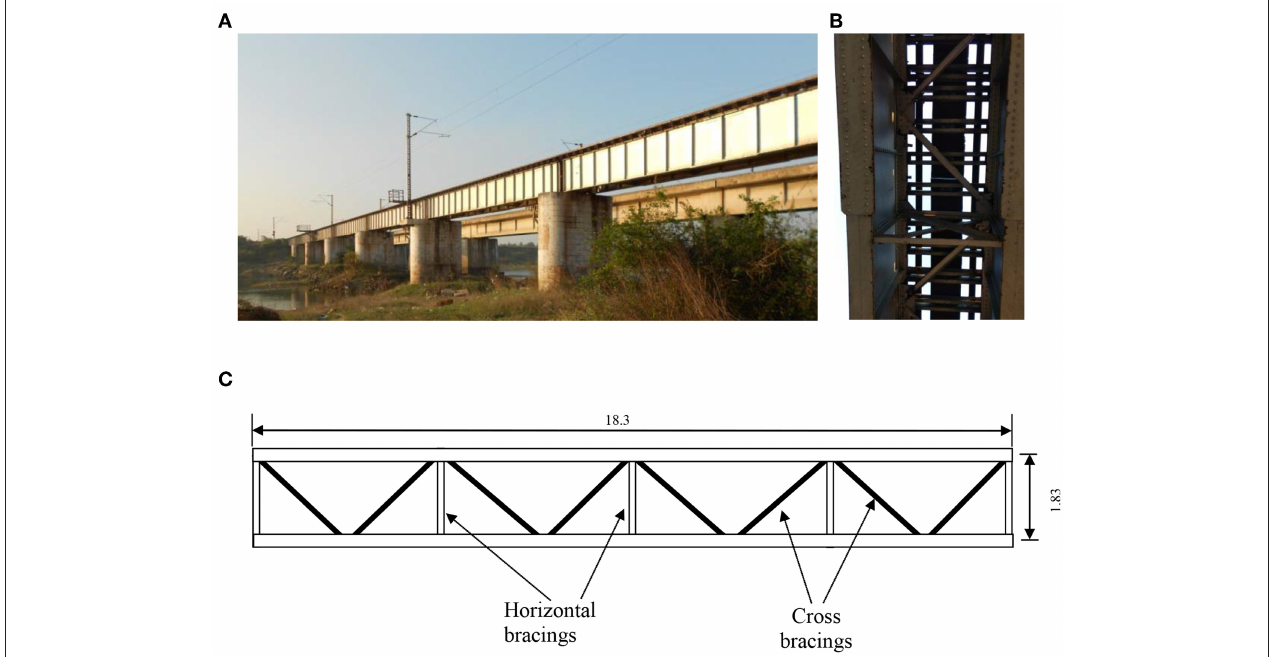
FIGURE 1 | Ponneri railway bridge. (A) Photo of the bridge. (B) View from bottom. (C) Plan.